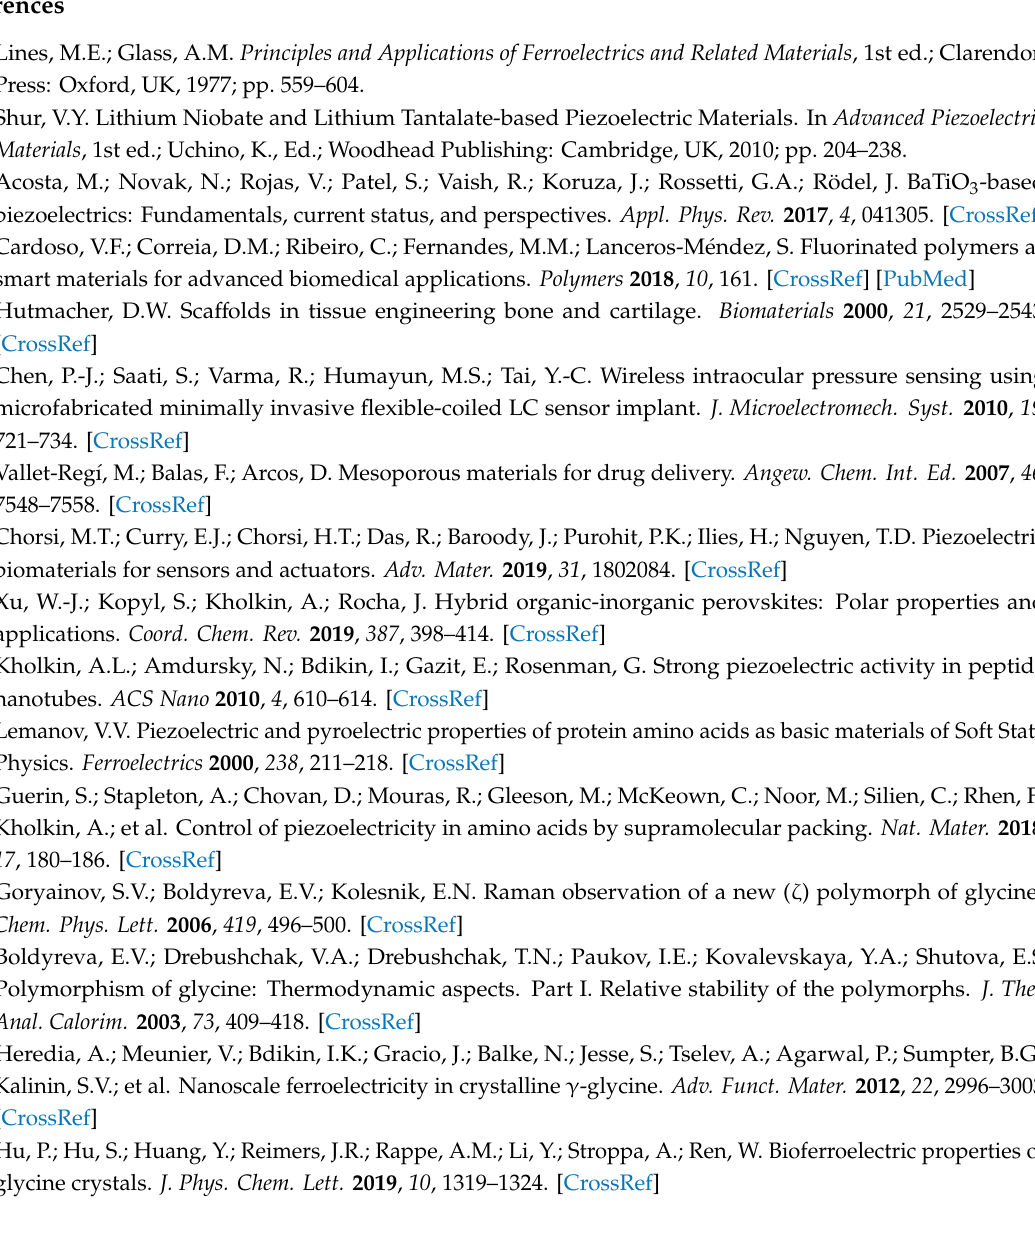
Figure S1: The distribution of the electric field under the probe in a β -glycine single crystal; Figure S2: AFM images of crystal surface and corresponding PFM images of as-grown domain